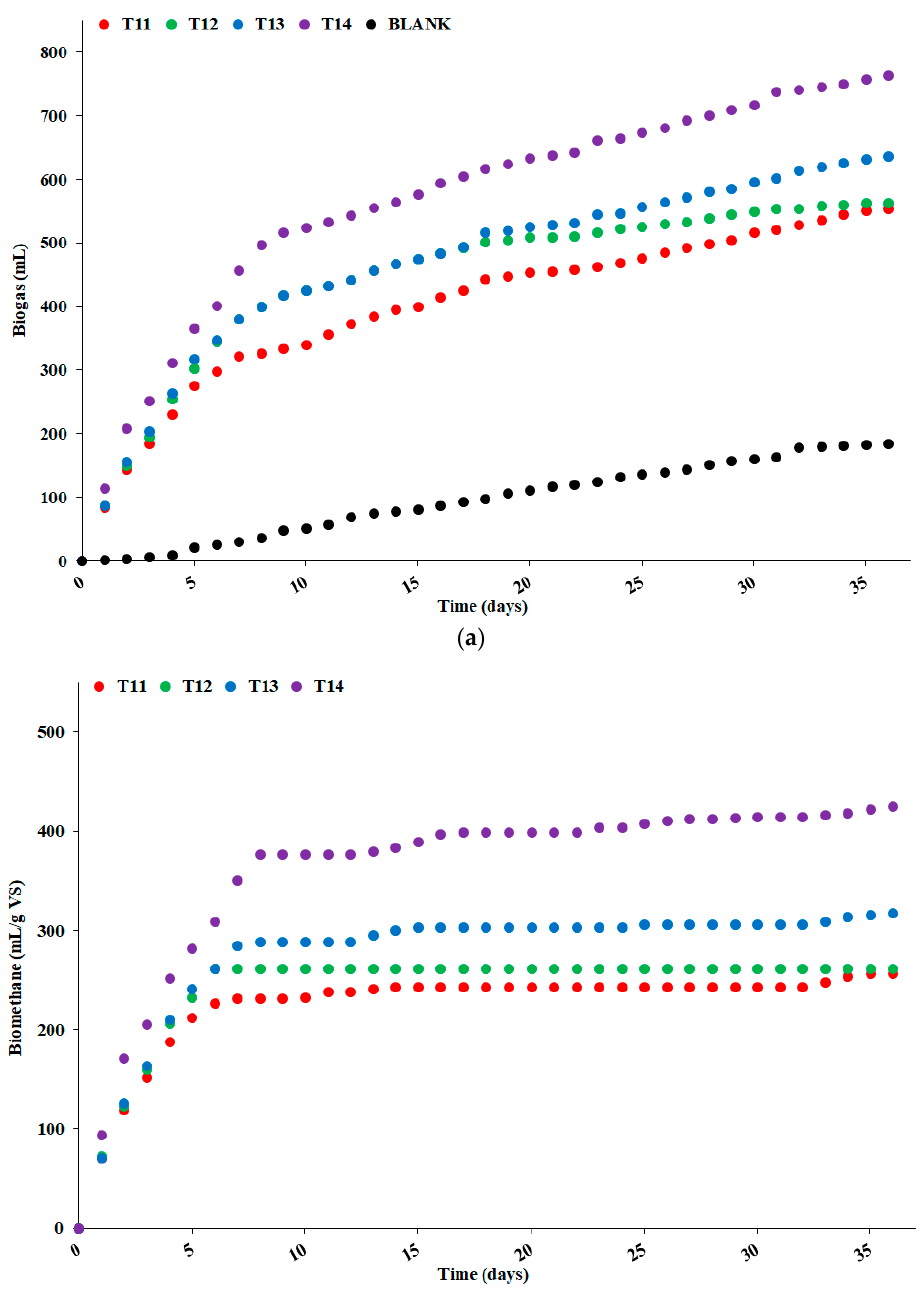
Figure 5. ( a ) Cumulated biogas generation from all the WOP1 test samples, including the blank sample; ( b ) cumulated methane production from all the WOP1 test samples, after subtraction of the generation from the blank sample.